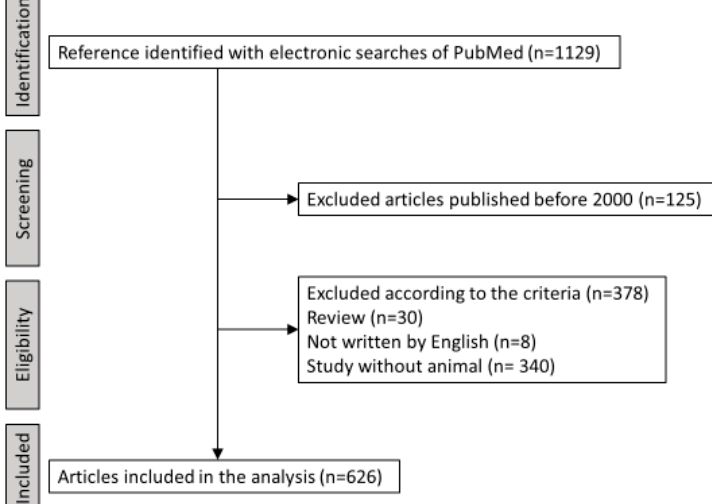
Figure 1. Flow chart for the selection of studies.